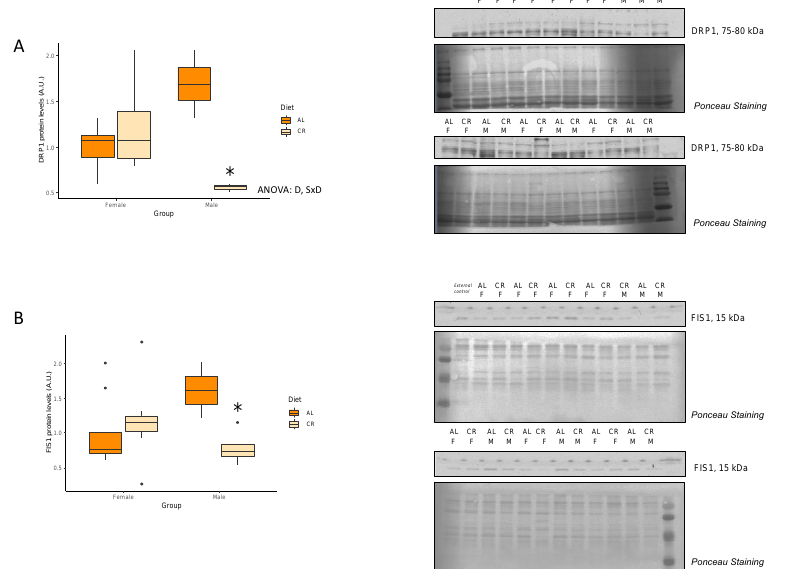
Figure 3. Effects of calorie restriction on proteins related to mitochondrial dynamics. Boxplots showing the protein levels of ( A ) DRP1 and ( B ) FIS1, and representative bands of the Western blot. Two-way ANOVA was performed to assess for significance. Abbreviations: SxD, interactive effect between sex and diet; D, diet differences; NS, non-significant; AL: ad libitum; CR: caloric restriction; F: female; M: male. * Significant difference between calorie-restricted and control group. Complex V or ATPase enzymatic activity was measured to obtain an indirect measure of skeletal muscle function. ATPase activity remained unchanged with CR in both sexes ( p -value = 0.429) (Figure S1). We observed a significant sex difference in ATPase activity ( p -value < 0.01), with females showing twice the activity as males. 3.3. Antioxidant Proteins Table 3 shows the mRNA levels and Table 4 the protein levels of several key antioxidant proteins that are involved in aging and modulated by CR in older age. Interestingly, in younger rats, we were not able to detect differences in most of these genes/proteins but there was an increase in the level of sirtuin 3 (SIRT3) protein in female CR rats (Figure 4). Interestingly, no changes were observed in acetylated levels of superoxide dismutase 2 (SOD2), a known target of SIRT3. On the other hand, NRF2 expression levels, a key transcription factor involved in antioxidant pathways, were different between males and females but not influenced by CR (Figure 4).